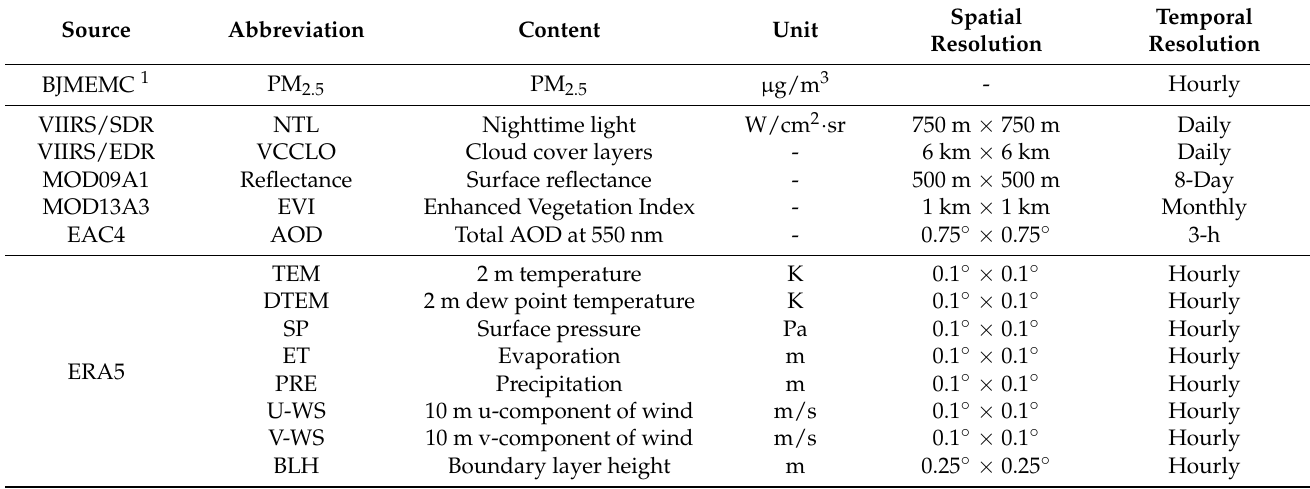
Table 1. Summary of datasets used in this